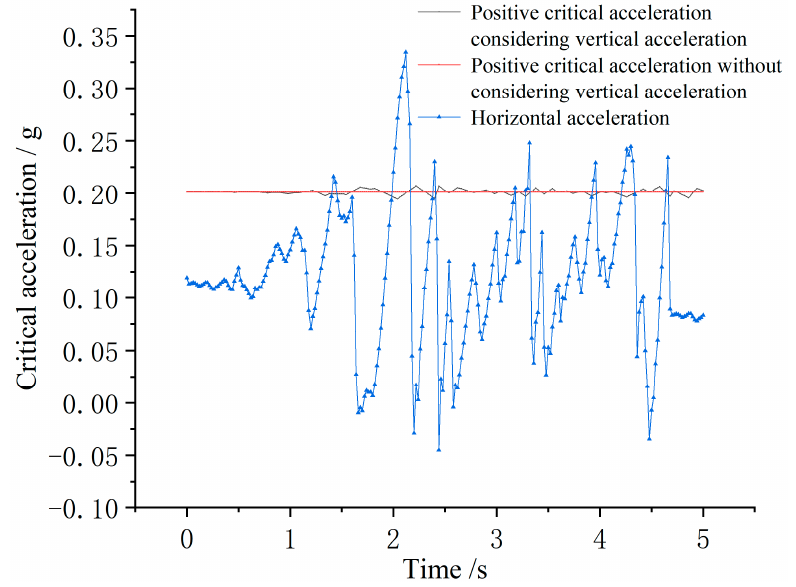
Figure 11. Horizontal acceleration and positive critical acceleration time history.